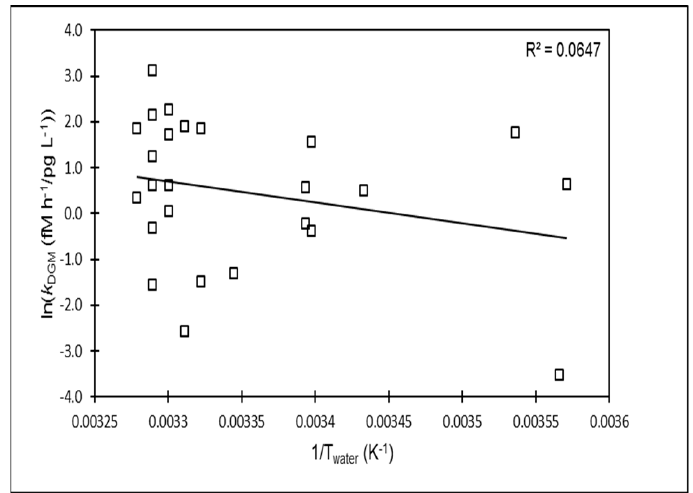
Figure 3. An Arrhenius relationship between the model-calculated rate constants of aquatic DGM photoproduction and water temperatures to investigate the impact of thermal energy on the Hg reduction. The model-calculated rate constants plotted include the entire calculated rate constants covering both warm and cold seasons.